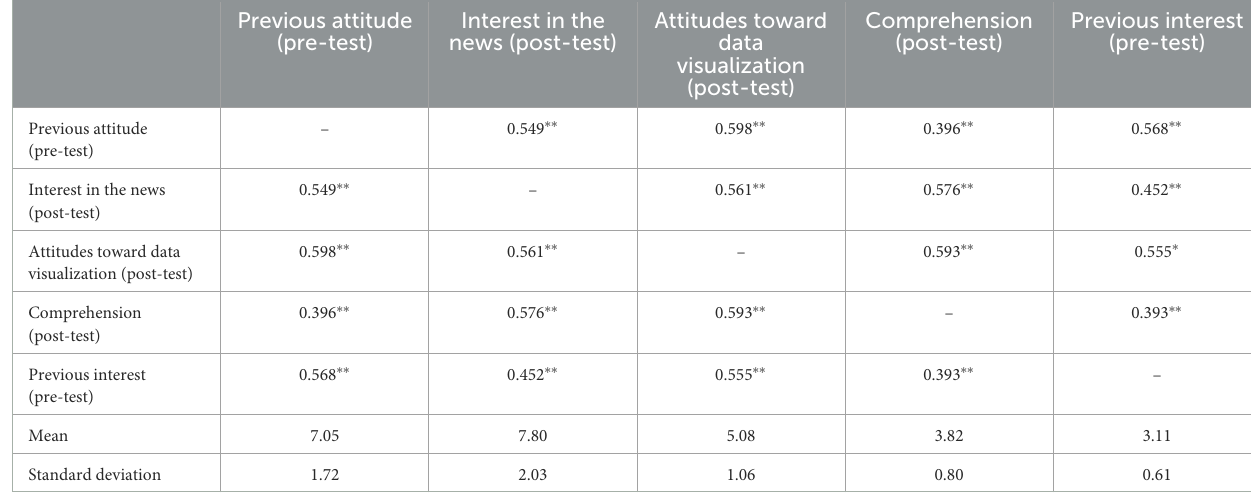
TABLE 1 Correlations between mediating, moderating, and dependent variables.